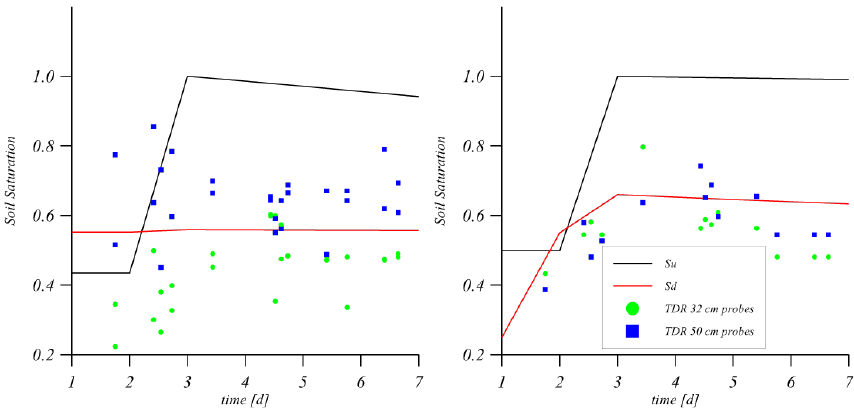
Fig. 10. Soil saturation estimated by mass balance at daily timescale, starting from 18 May 2010 (before the 13mm rainfall event) and soil saturation measured by fixed TDR probes. Left panel: fallow plot. Right panel: cultivated